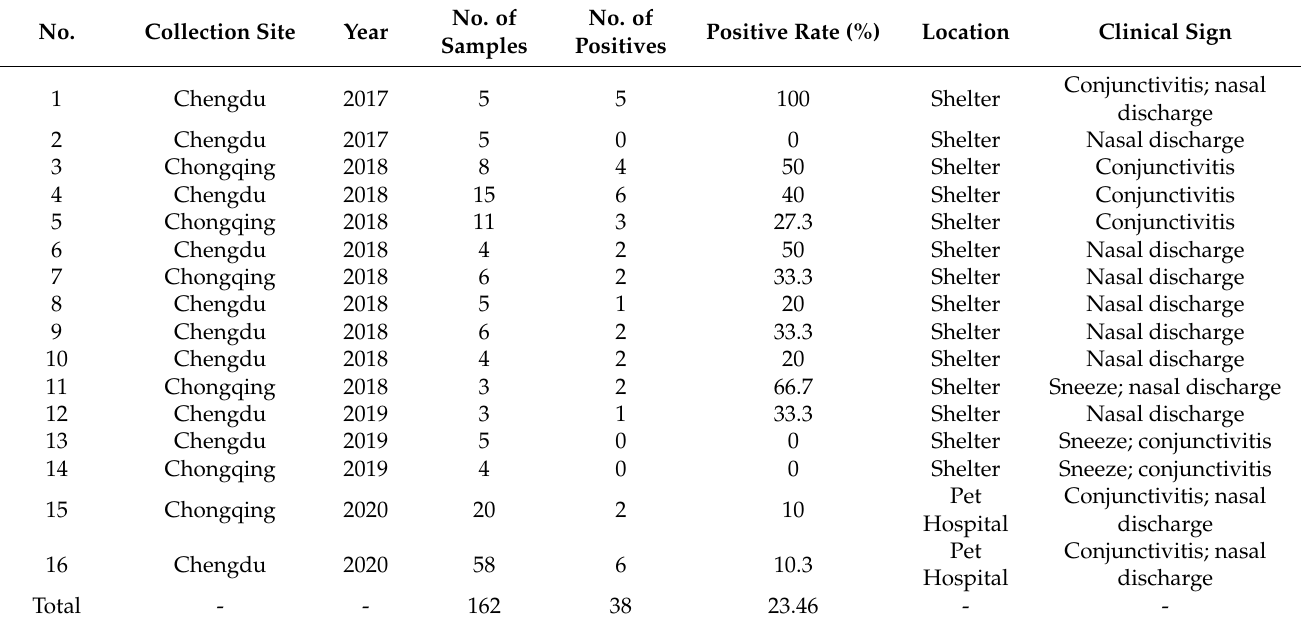
Table 1. Information on the clinical specimens in this